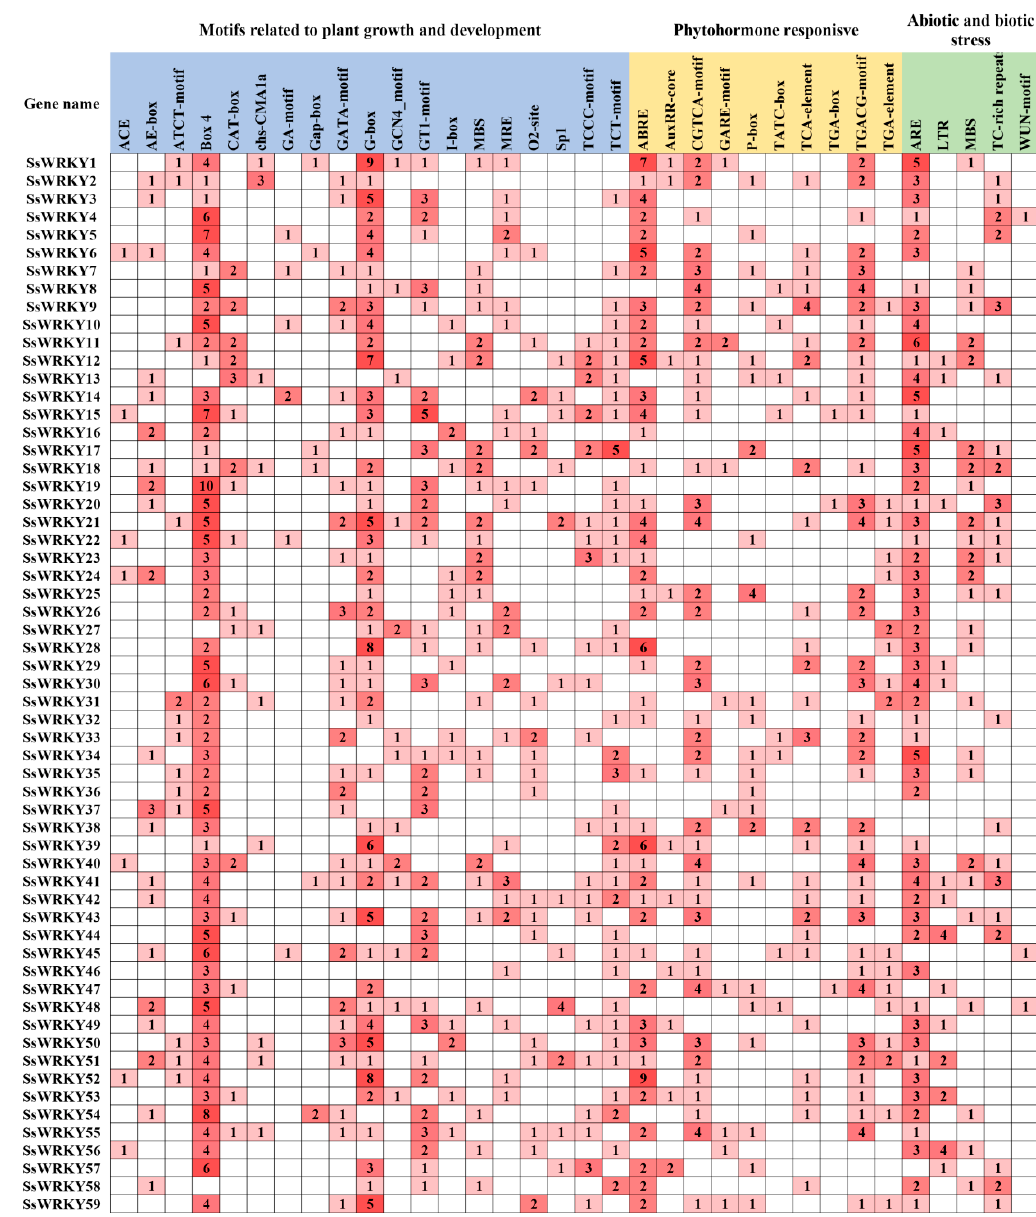
Figure 6. Cis -acting elements analysis in the promoter region of SsWRKY genes. The number of cis - acting elements are shown by the digits. The greater the quantity, the darker the color. Light blue, yellow, and green represent three categories of cis -acting elements related to plant growth and development, phytohormone response, and abiotic and biotic stress.